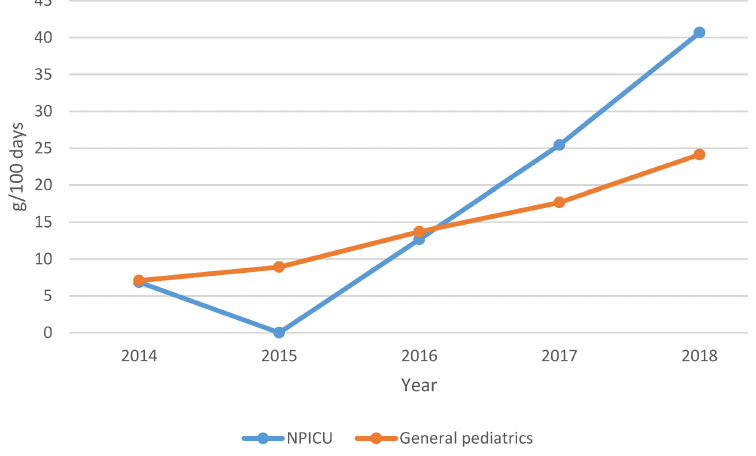
Figure 3: Piperacillin-tazobactam